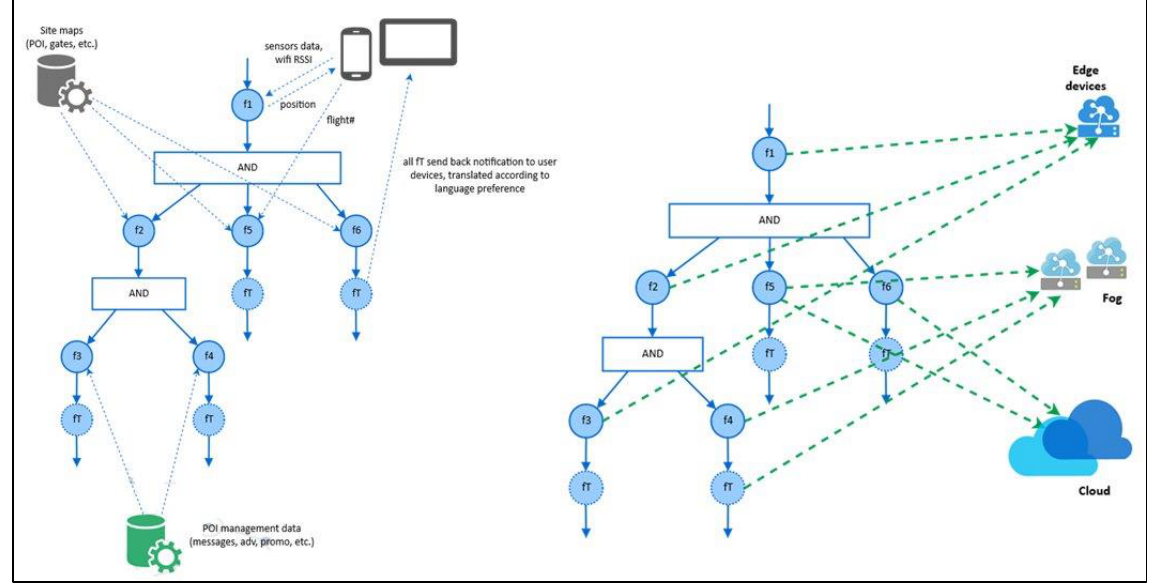
Figure 8. design oriented to set of microservices